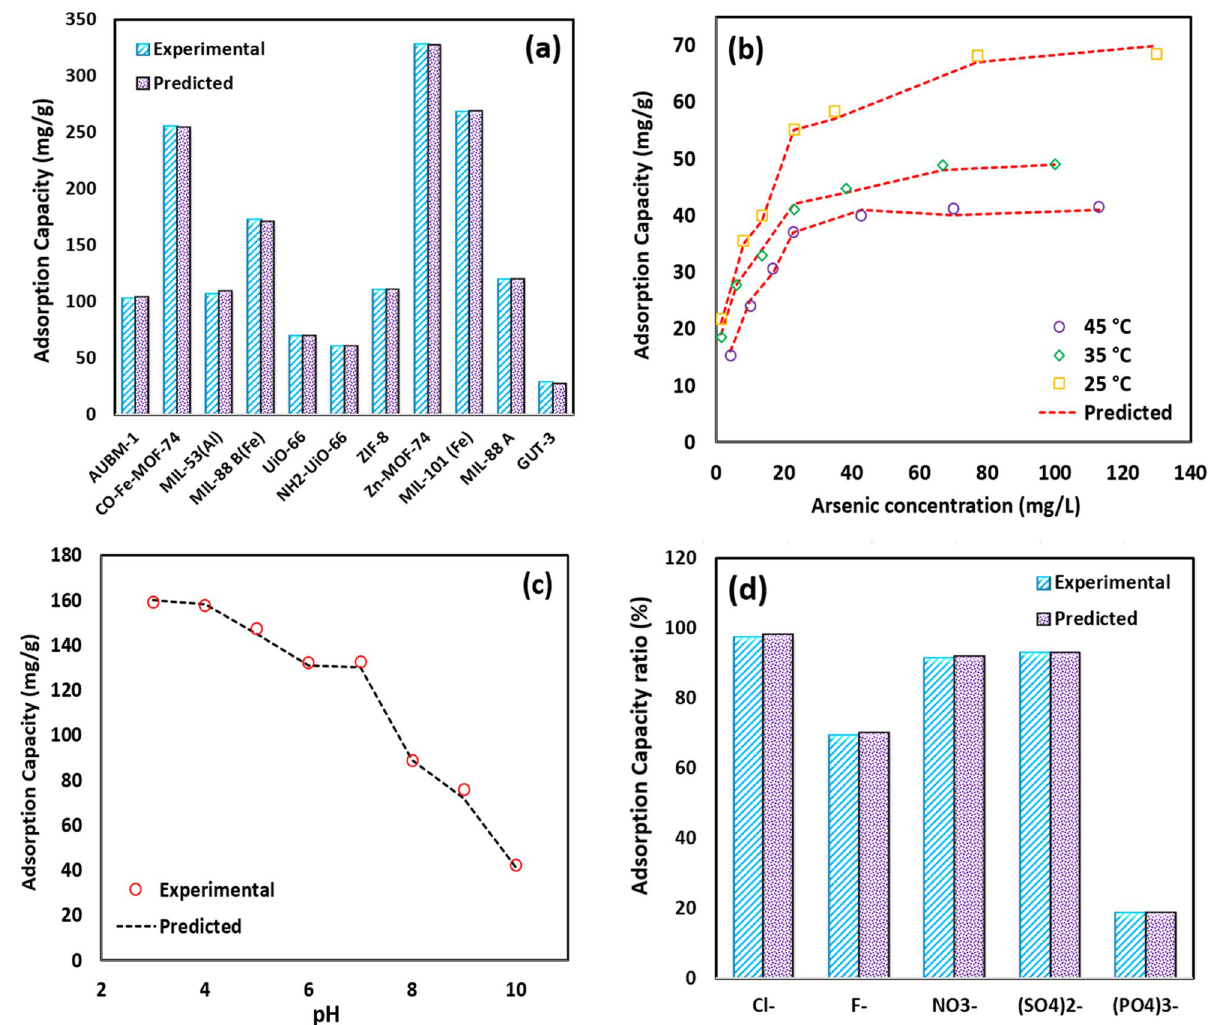
Figure 7. ( a ) The performance of different MOFs in the adsorption of As(V), ( b ) The effect of temperature on the adsorption capacity of UiO-66-NH 2 in different As(V) concentration (pH = 9.2), ( c ) The effect of solution pH on arsenic removal by Fe-Co-MOF-74 (Initial arsenic concentration = 100 mg/L, adsorbent dose = 0.5 g/L, temperature = 25 °C), and ( d ) The effect of competition anions on the adsorption capacity of ZIF-8 (pH =